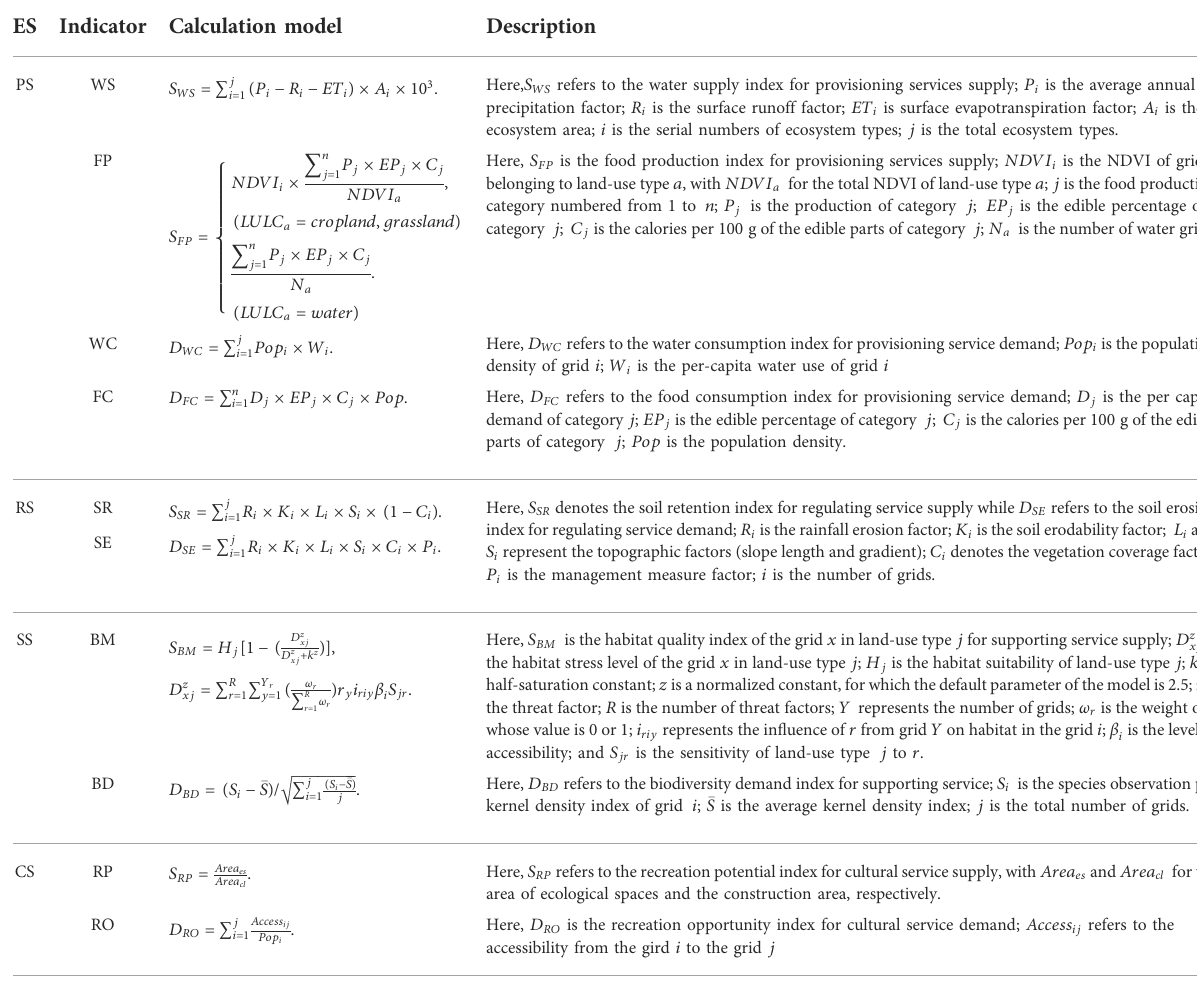
TABLE 2 Indicators and calculation models of four